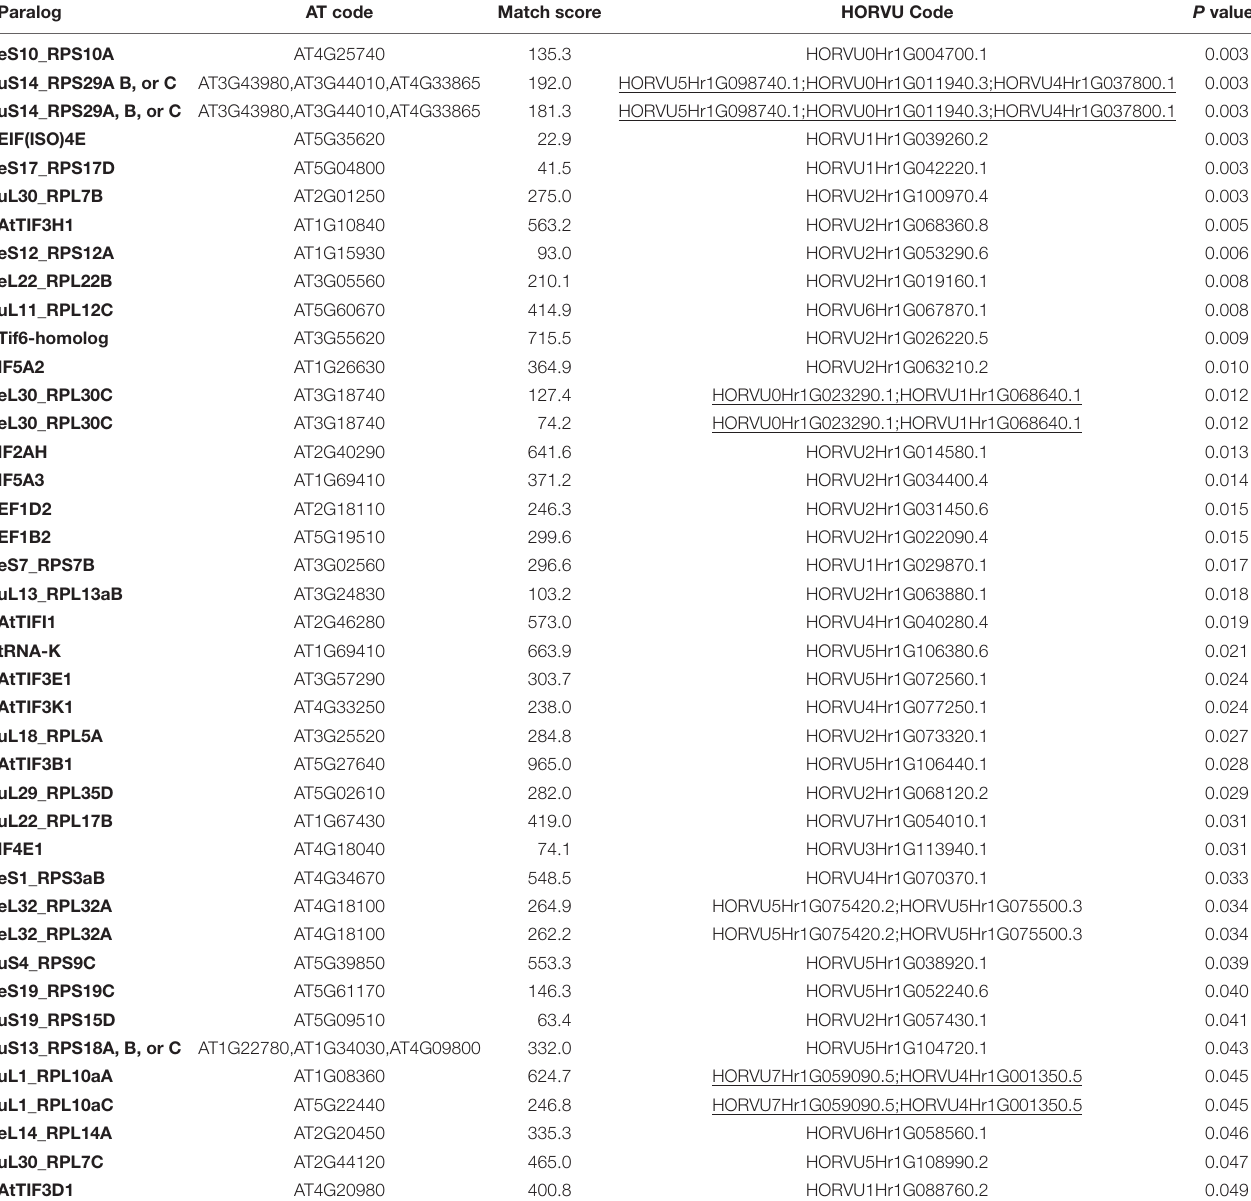
TABLE 2 | Statistics of cold acclimated and homology alignments of significantly changed- Arabidopsis thaliana (AT) and Hordeum vulgare (HORVU) RP and RAP paralogs outlined in Figure 6 . Paralog AT code Match score HORVU